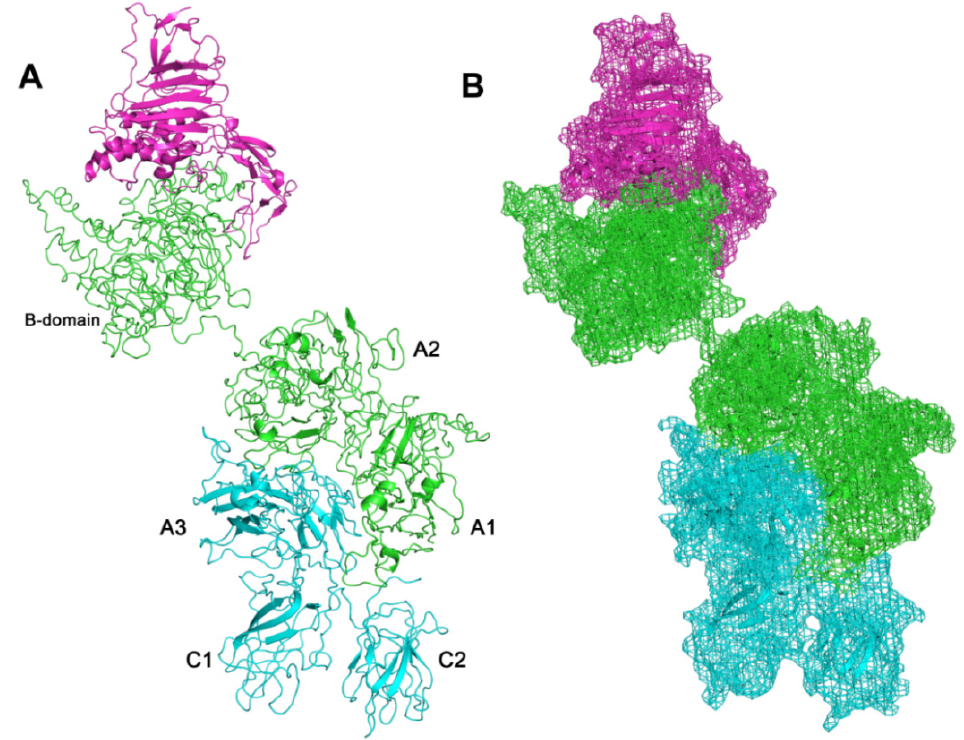
Figure 2. VWF/FL-FVIII complex. ( A ) FL-FVIII is represented in cyan (light-chain) and green cartoons (heavy-chain, including domain ( B )), VWF is represented with magenta cartoon. ( B ) Surfaces representation as mesh. Capital letters refer to protein domains of FVIII.